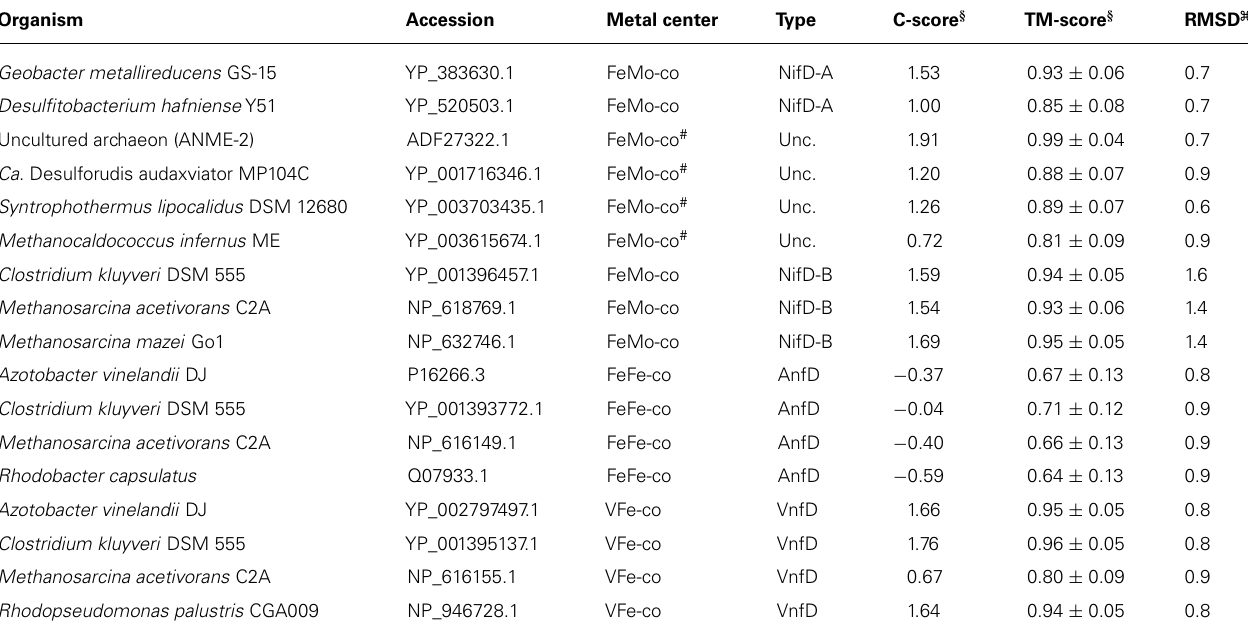
C score andTM-scores are internal I-TASSER generated scores for estimating the quality of predicted models. C-scores exist in a range of [ − 5,2], where a C-score of higher value signifies a model with a high confidence (Wu etal., 2007; Roy etal., 2010). TM-score indicates topological similarity of protein structure pairs and estimated accuracy with a range of [0, 1]. A score of 1 indicates perfect structural similarity (Sali and Blundell, 1993). RMSD values in the table were calculated using DaliLite (Holm and Park, 2000) against the NifD subunit of the high resolution Nif 1M1N structure (Einsle etal., 2002). Uncharacterized nitrogenases are abbreviated as “Unc.” § Internal I-TASSER generated score.